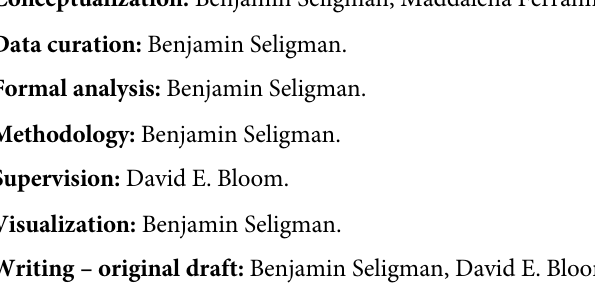
S1 Fig. Simulated proportions of deaths by race/ethnicity. Figure shows mean and 2.5th– 97.5th percentile range for the simulations (gray bars and whiskers), the CDC-reported pro- portions (blue circles), and the NHANES-estimated proportions for the general population (red triangles). AA, African American; AAPI, Asian American/Pacific Islander; NHW, non- Hispanic